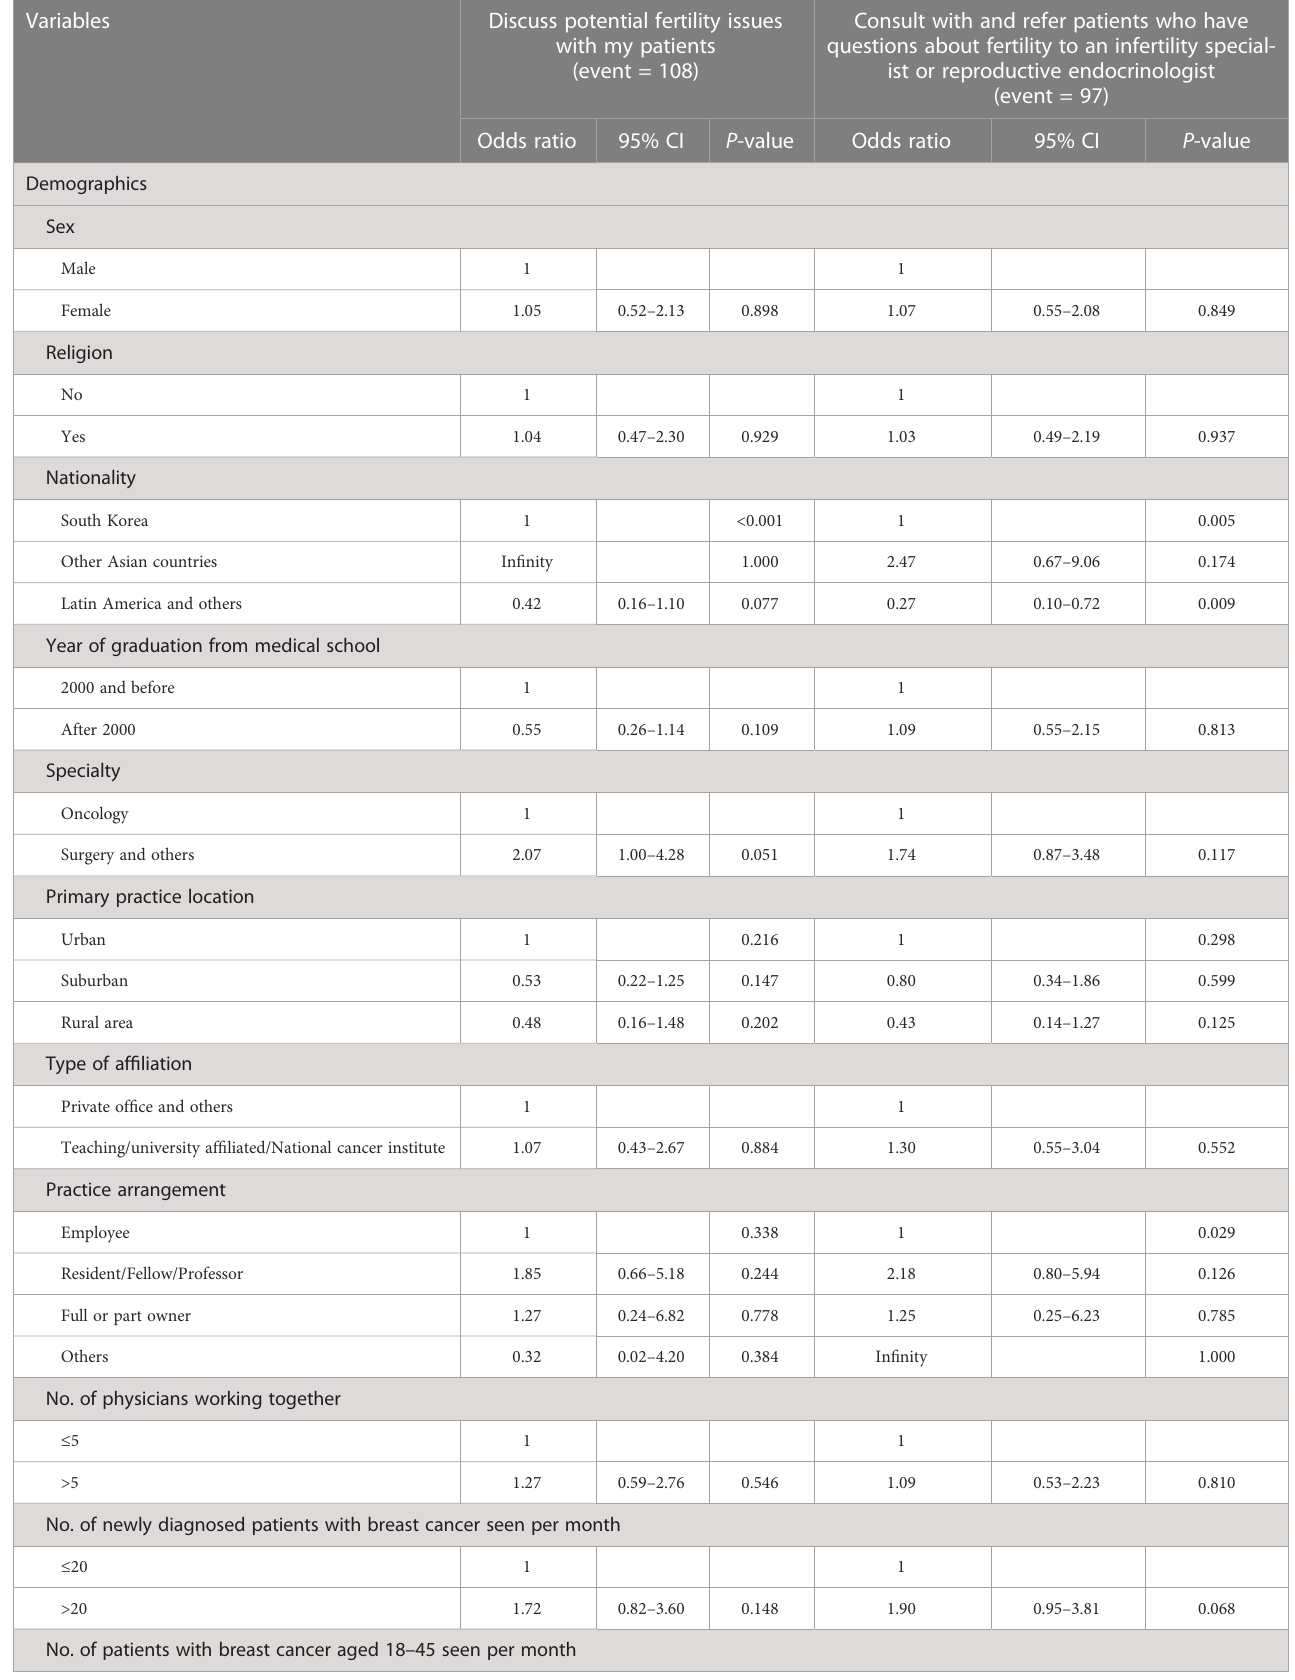
TABLE 2 Univariate analysis.